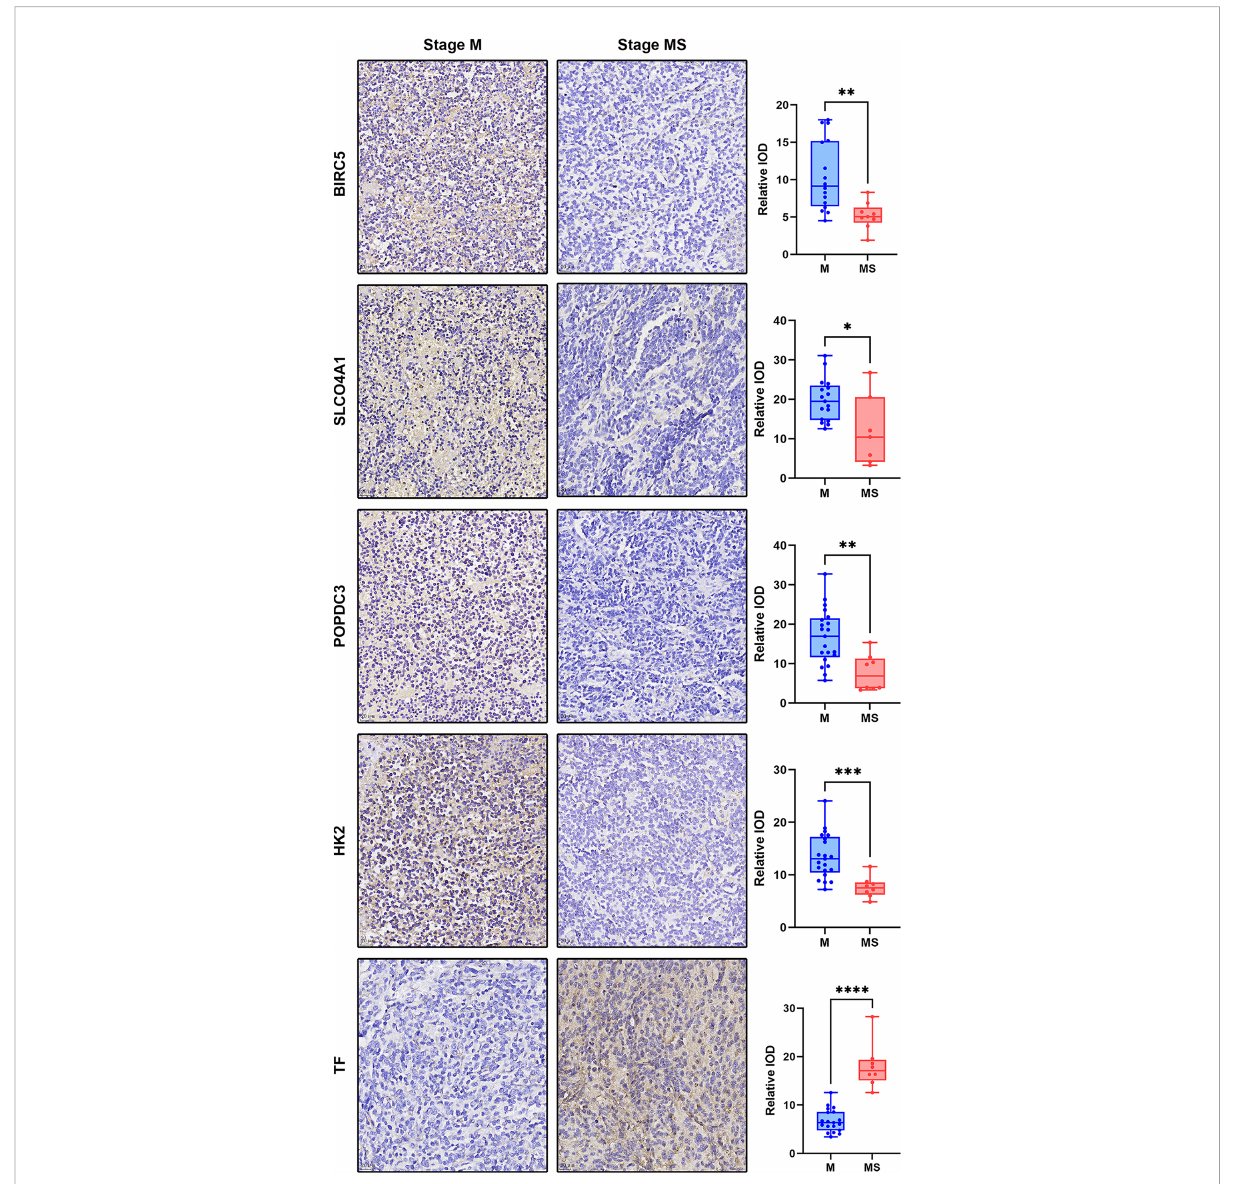
FIGURE 6 Display of IHC dyeing effect of DEGs and the dot plot of relative IOD values of each group. The magni fi cation of the IHC images was 40×, scale bar=20 m m. The dot plot shows the difference of IOD values between samples of each protein in M and MS stage. *p < 0.05, **p < 0.01, ***p < 0.001, ****p <